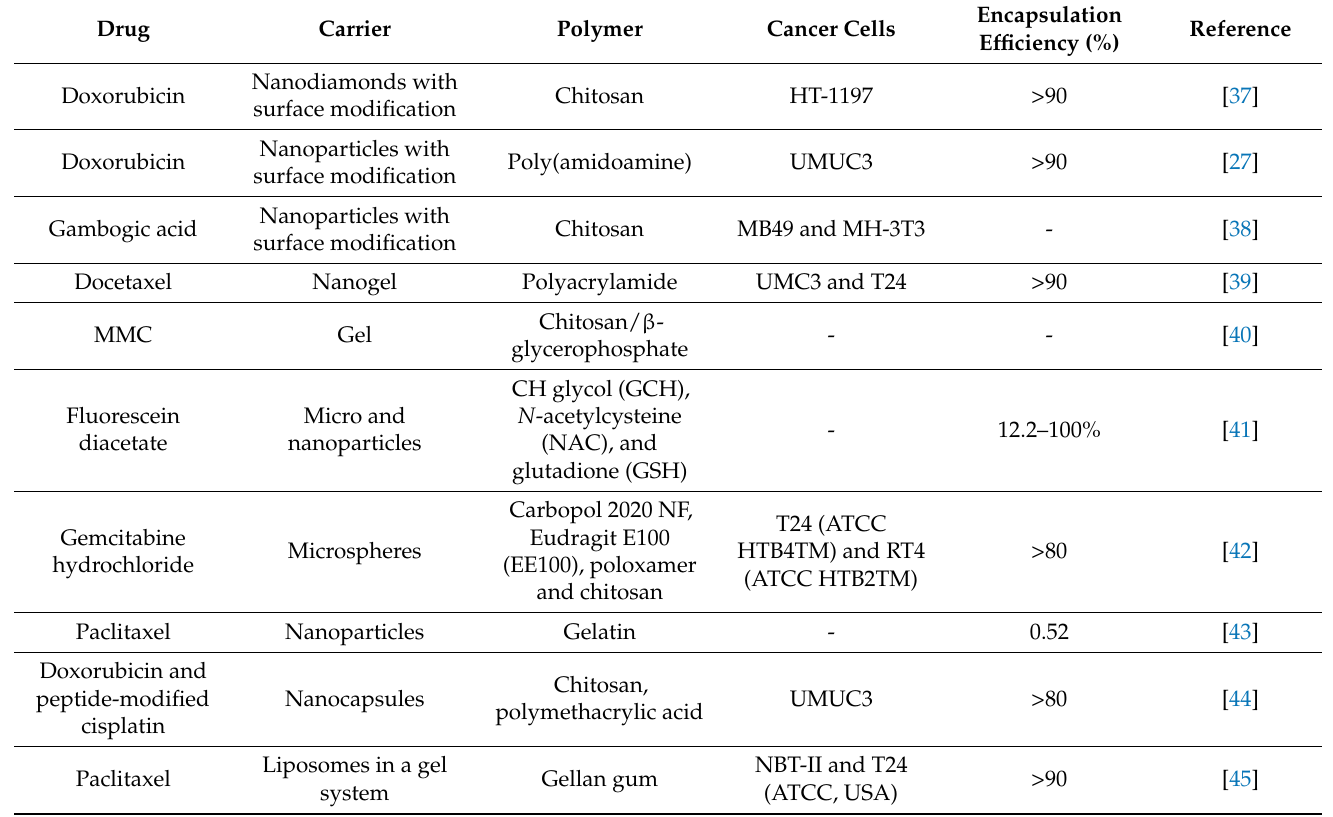
Table 1. Mucoadhesive polymeric systems for controlled drug release in the bladder—advanced